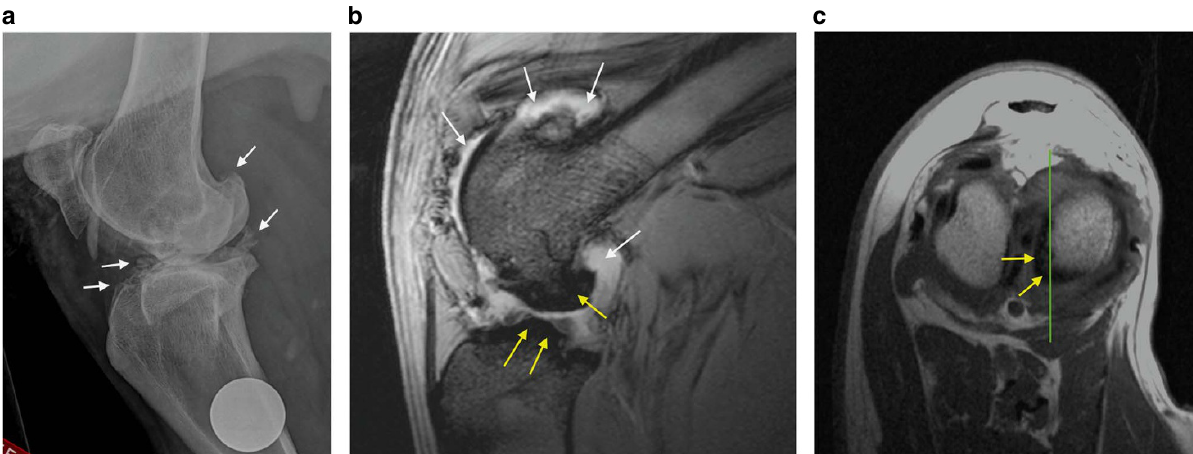
Figure 6 | Images of the right stifle joint of Clone 2262. ( a ) Mediolateral radiographic view of the right stifle of Clone 2262. White arrows indicate osteophytes/new bone formation at joint margins, with bone remodelling. This joint was scored as Grade 3 on the modified scale of Kellgren and Lawrence 38 . The circular opacity is a 25mm coin, placed as marker to indicate the right limb. ( b ) Sagittal T2* MRI scan of the same stifle joint. ( c ) Transverse T1 MRI scan of the same stifle joint. The green lines on this image show the level corresponding to the sagittal image shown in b . In the MRI scans, bone appears hypointense (dark), while fat and fluid appear hyperintense (white). The irregular new bone formation on the femur and tibia are indicated by the yellow arrows. The white arrows indicate synovial fluid and fat within